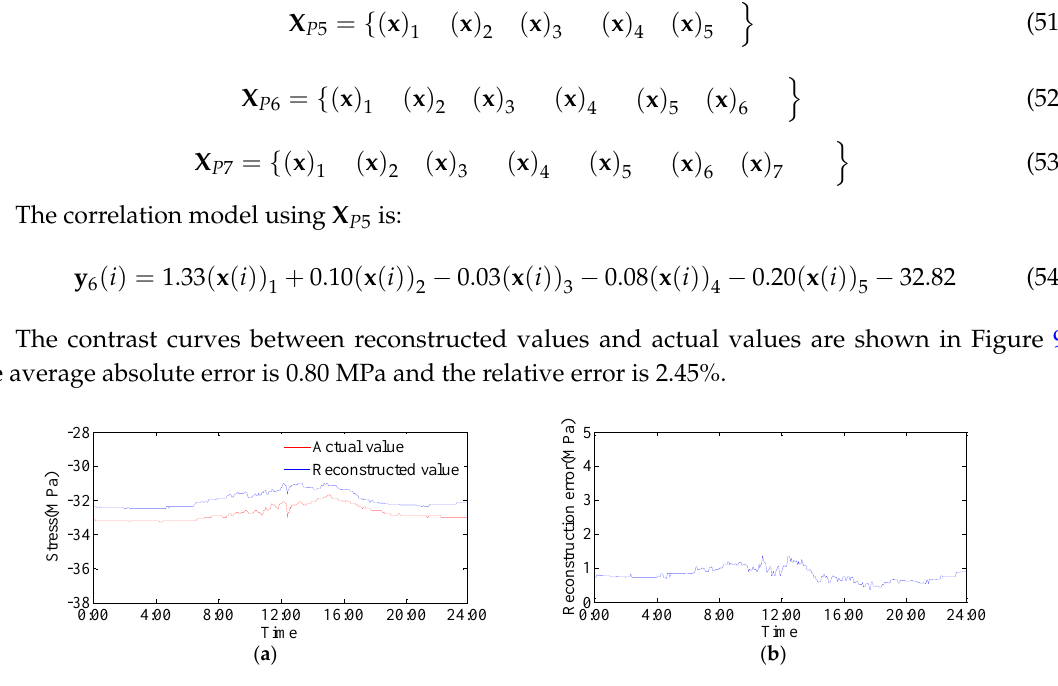
The errors of the reconstructed information using stress monitoring data from different time